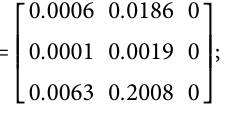
Figure 10: Box plots of values of parameters in equation (3) of the averaged (z) – locations of the NiCrAlY and the ZrO single powder injection from 50